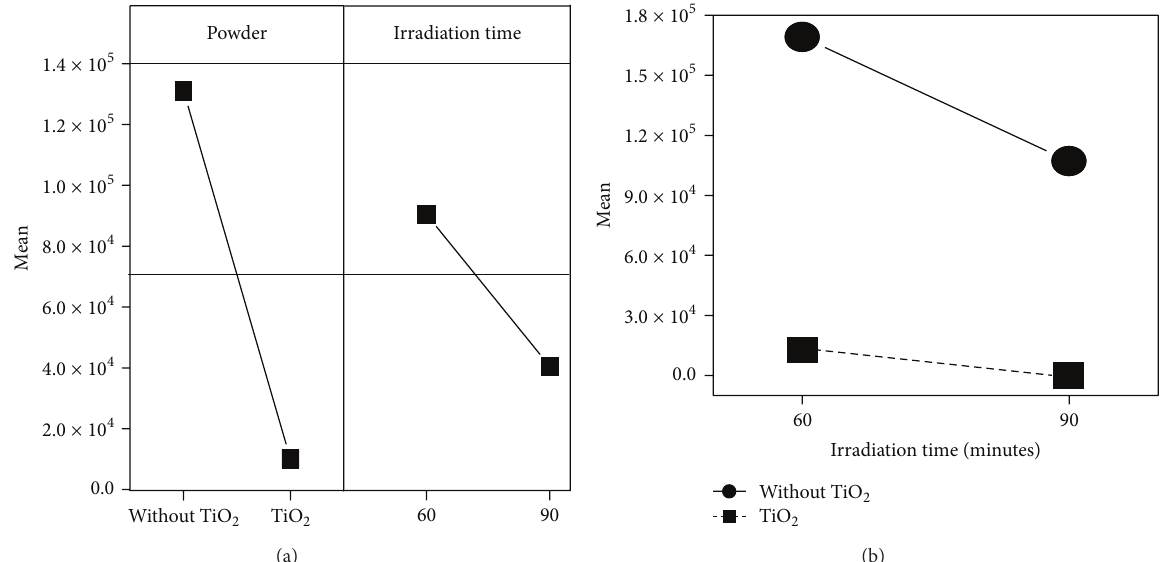
Figure 5: Principal effects and interaction between light and TD on the Pseudomonas aeruginosa survival at TD concentration 0.5 mgmL −1